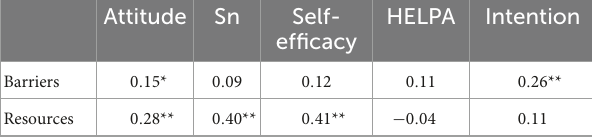
TABLE 8 Pearson correlations of IH-RHAC scales with barrier and resource scales.